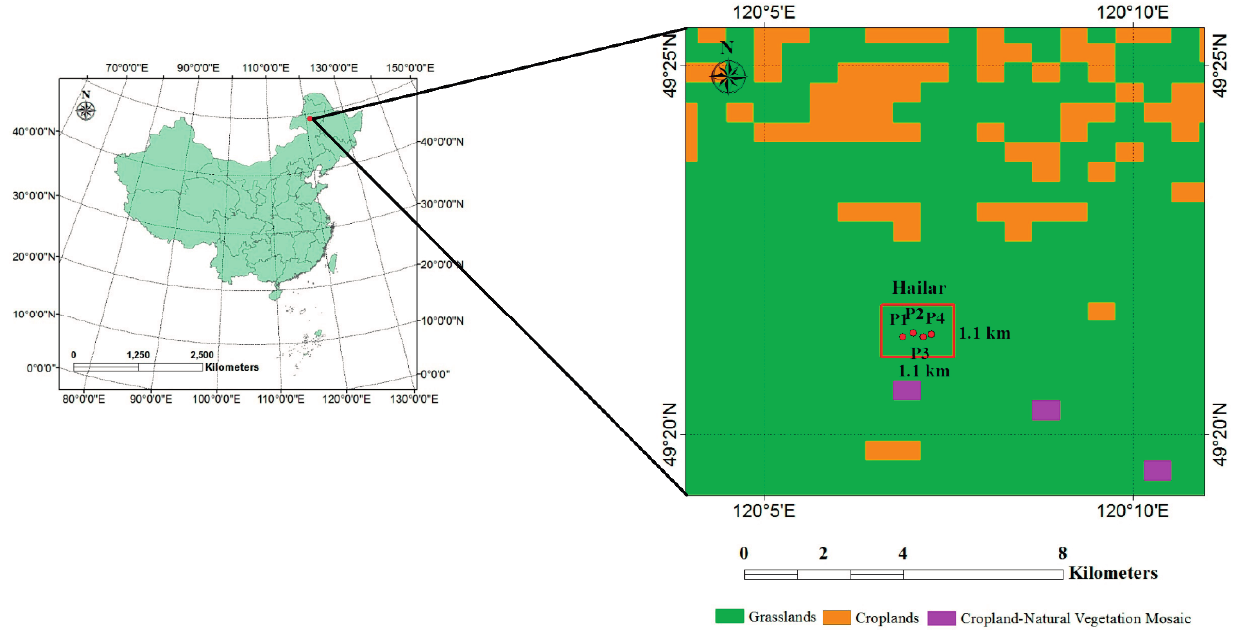
Figure 1. Location of the study site (the four red points in the red rectangle show the locations of the installed infrared